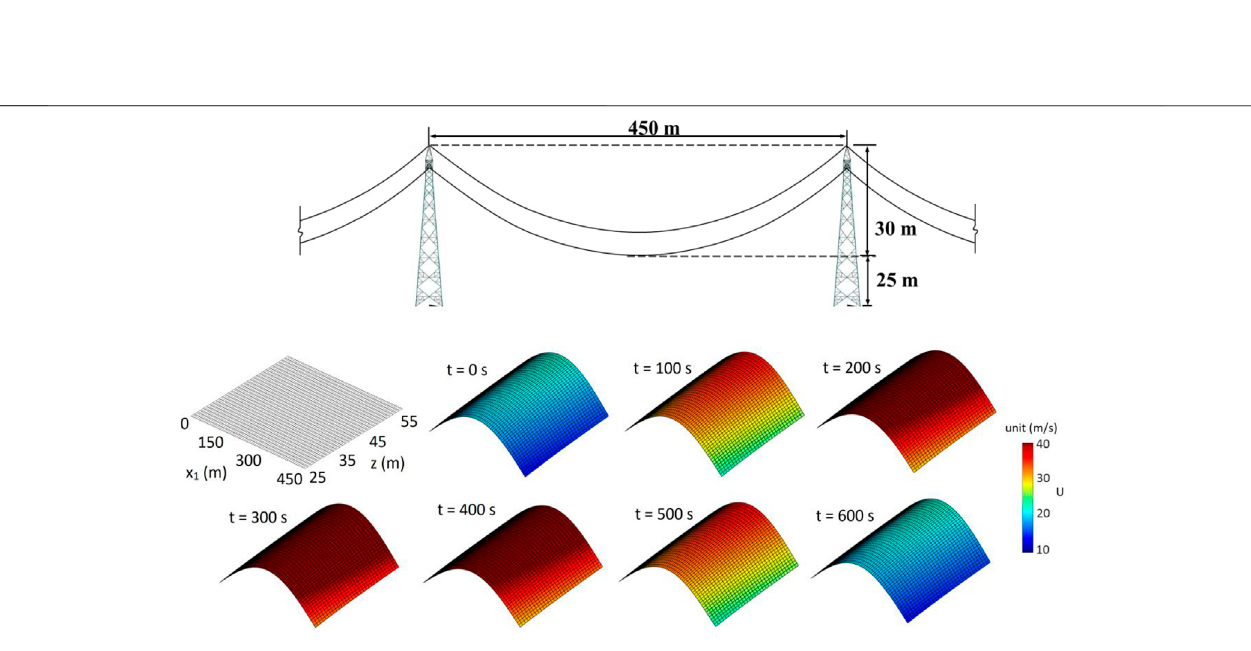
Frontiers in Built Environment |